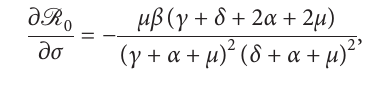
� 2 . 525; (b) σ � 0 . 02, α � 0 . 025, R 0 � 0 . 0